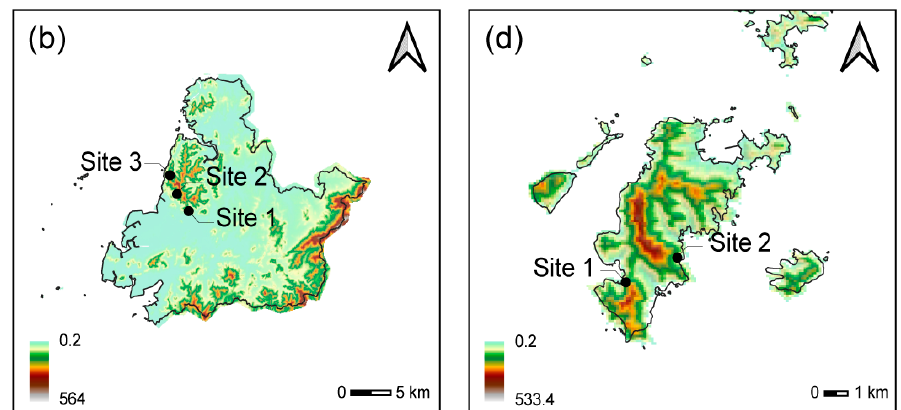
Figure 1. Sampling sites of spring orchids ( Cymbidium goeringii Lindley) from ( a ) South Korea, ( b ) Yeonggwang-gun, ( c ) Ulleung Island, and ( d ) Heuksan Island. Di ff erent colors on the map indicate di ff erent elevations (m). Arrows indicate the direction of the yellow dust winds